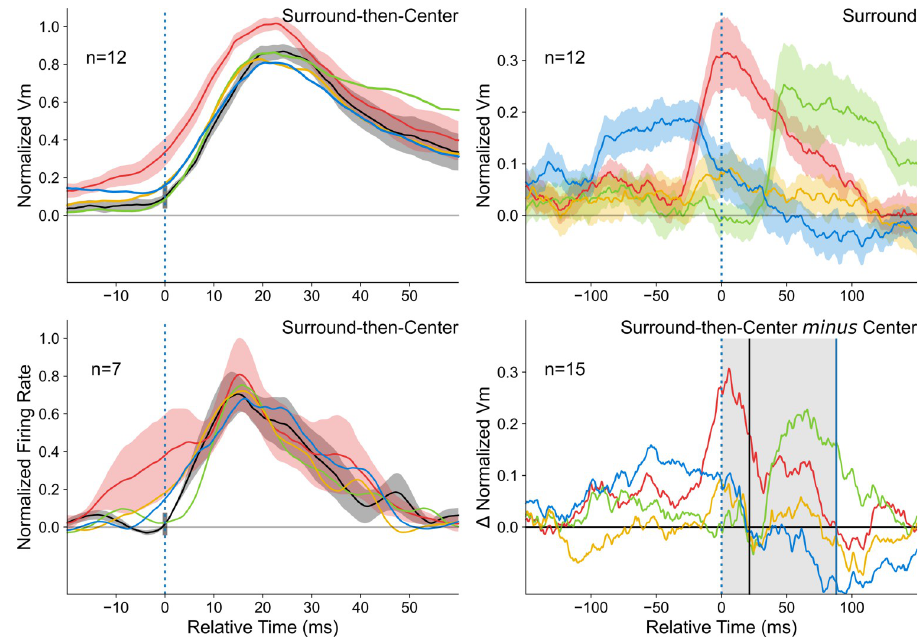
Fig 9. Mechanistic analysis of the “Filling-in” contribution to contextual gain control. Left, contextual gain control analysis, restricted to the population of cells (n = 12) showing significant “filling-in” responses. Mean responses, averaged for each AM flow pattern (CP-ISO (red), CF-ISO (light green), CP-CROSS (gold) and RND-ISO (blue)) are represented at the Vm (top panel) and spiking levels (bottom) with their (shaded) S.E.M. envelopes. Same color code as in Fig 1C. The selective latency advance and amplification of the subthreshold response induced specifically by the CP-ISO condition (top, n = 12) translate at the spiking level in cells displaying spiking activity (bottom, n = 7). Right , comparison of the contextual time course of Surround- Only responses with the predicted contribution of the Surround, according to an additive model. Top , observed traces (n = 12); Bottom, linear predictors of the Surround- Only responses obtained by subtracting the “Center- Only” trace from the “Surround-Then-Center” response. The predicted profiles were calculated independently for each contextual condition (same color code). The averaging process was extended to all cells showing a significant contextual change in latency and/or response integral (n = 15, see Text for detailed criteria). The expected occurrence of the response evoked by the omitted Center stimulus is indicated by a grey shaded temporal window. The time abscissa of the peak of the “Center-Only” stimulus response is indicated by a thin vertical bar.